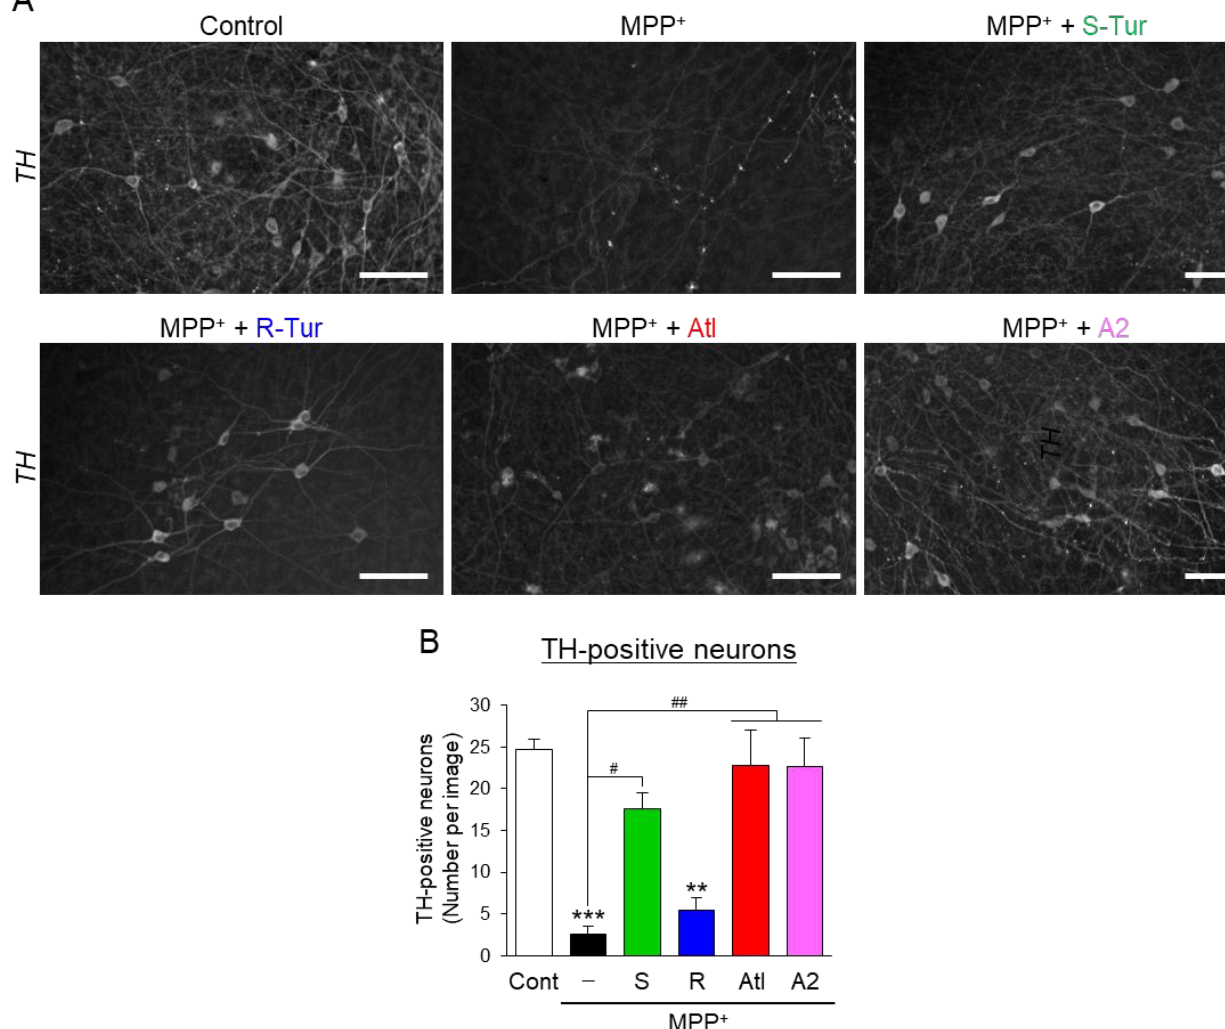
Figure 5. Effects of ar-turmerone analogs on microglial activation triggered by treatment with MPP + in midbrain slice cultures under microglial reduction. ( A ) Representative images of TH immunoreactivity in PLX5622-treated midbrain slice cultures under control conditions, treatment with MPP + alone, and cotreatment with MPP + and 20 µ M ar-turmerone analogs. Scale bars, 100 μm. ( B ) Quantitative analyses of TH-positive neurons in midbrain slice cultures. Data are presented as the mean ± SEM of three independent samples. ** p < 0.01, *** p < 0.001 vs. control, # p < 0.05, ## p < 0.01 (n = 3, one-way ANOVA, followed by a post hoc Tukey test).